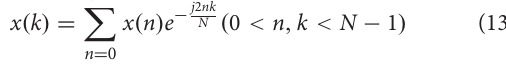
FIGURE 6 | Power spectrum curve of channel transfer function.